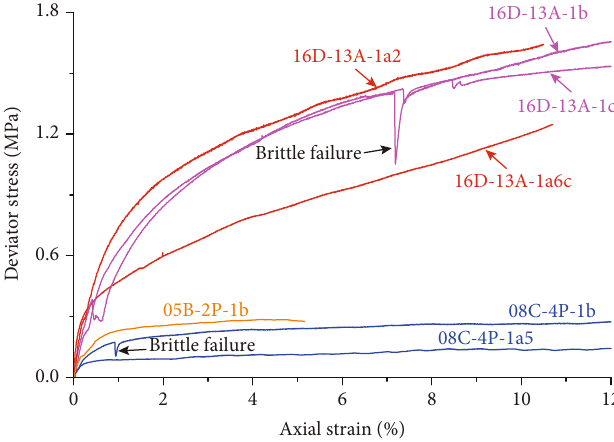
Figure 5: Deviatoric stress versus axial strain during the PCATS triaxial